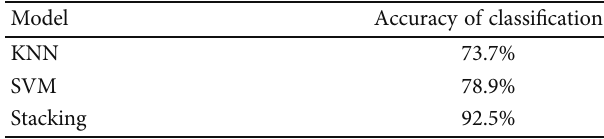
Table 9: Model prediction results optimized by genetic